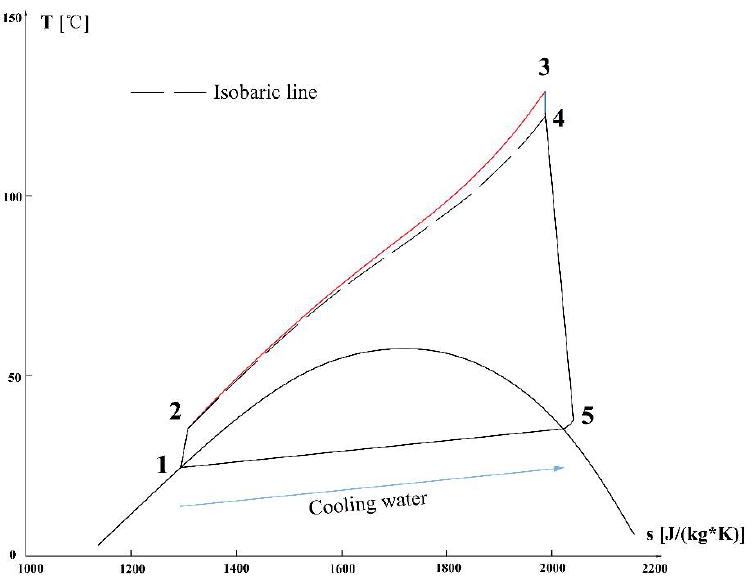
Figure 2. Temperature-entropy (T-s) diagram of the power cycle corresponding to the power gen- tion system shown in Figure 1 (geofluid temperature = 130 ◦ eration system shown in Figure 1 (geofluid temperature = 130 °C).